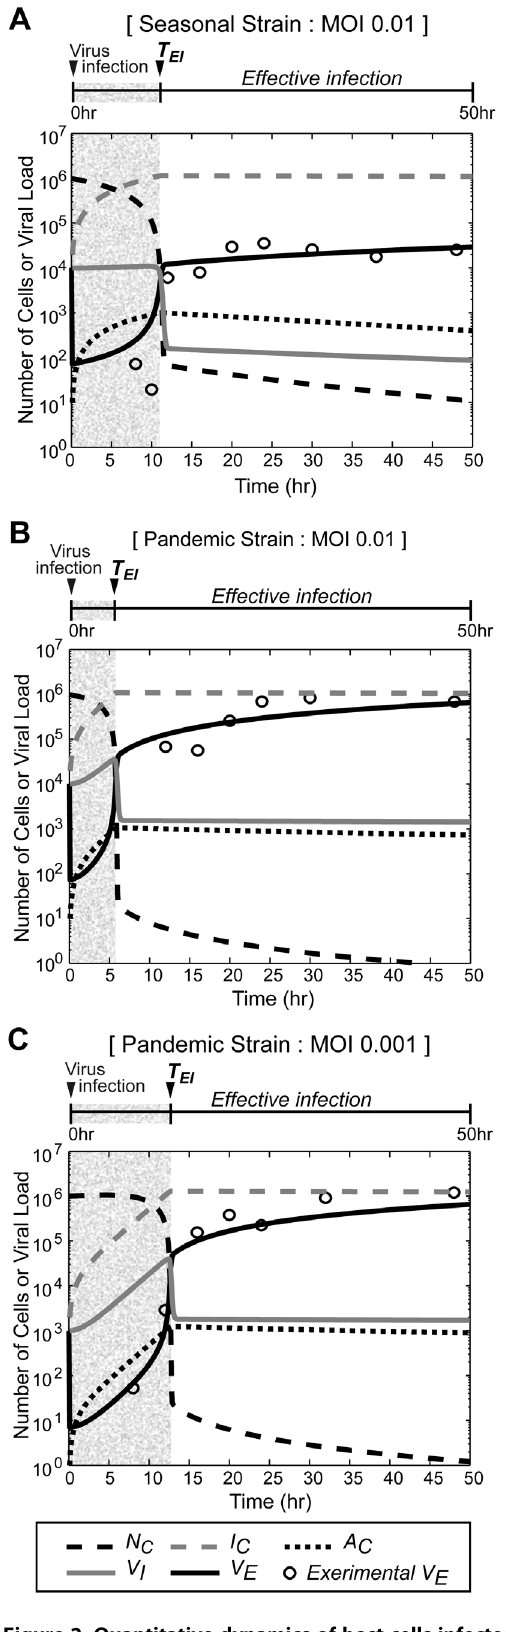
Figure 2. Quantitative dynamics of host cells infected with the seasonal and pandemic strains of influenza virus. The